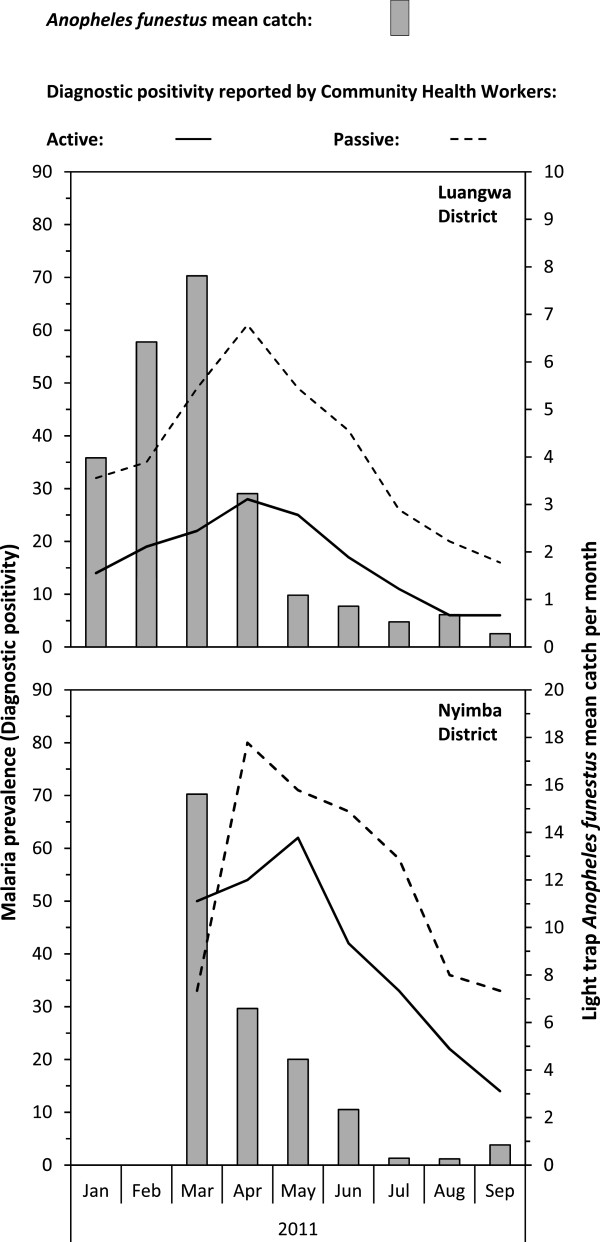
Temporal variations of
Anopheles funestus
mean catches by light traps and the malaria diagnostic positivity among human residents from January to September 2011 in Luangwa and Nyimba districts.